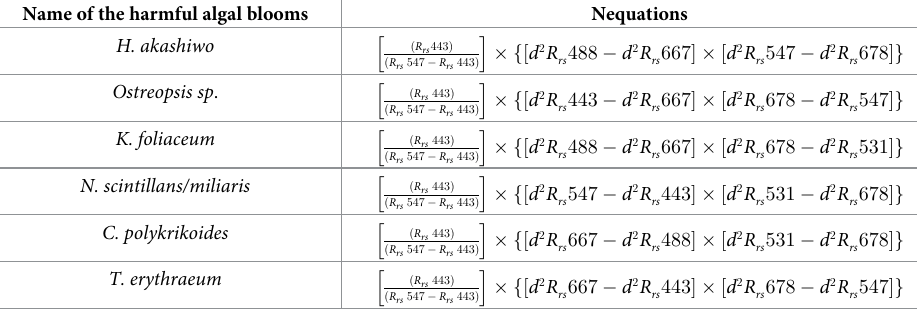
Table 3. Different sets of nequations for each HAB species based on the band-ratios/difference algorithm and dif- ference in their derivative spectra. Name of the harmful algal